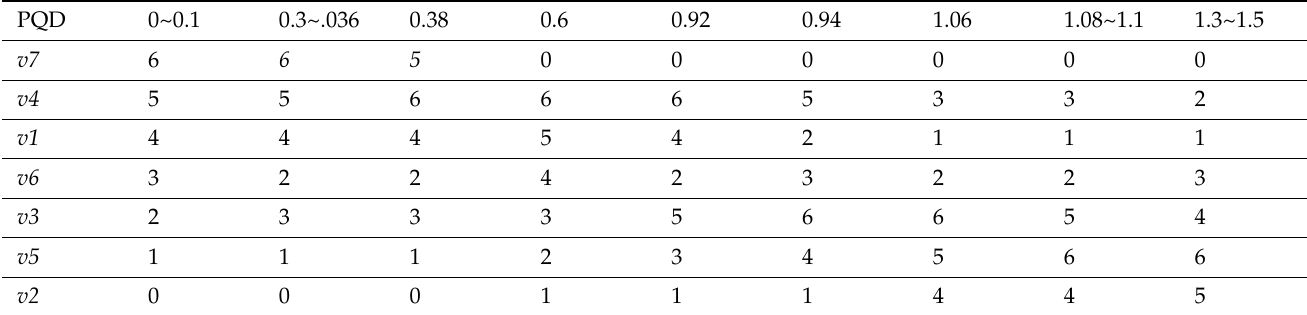
Table 9. Scores of complex disturbances.